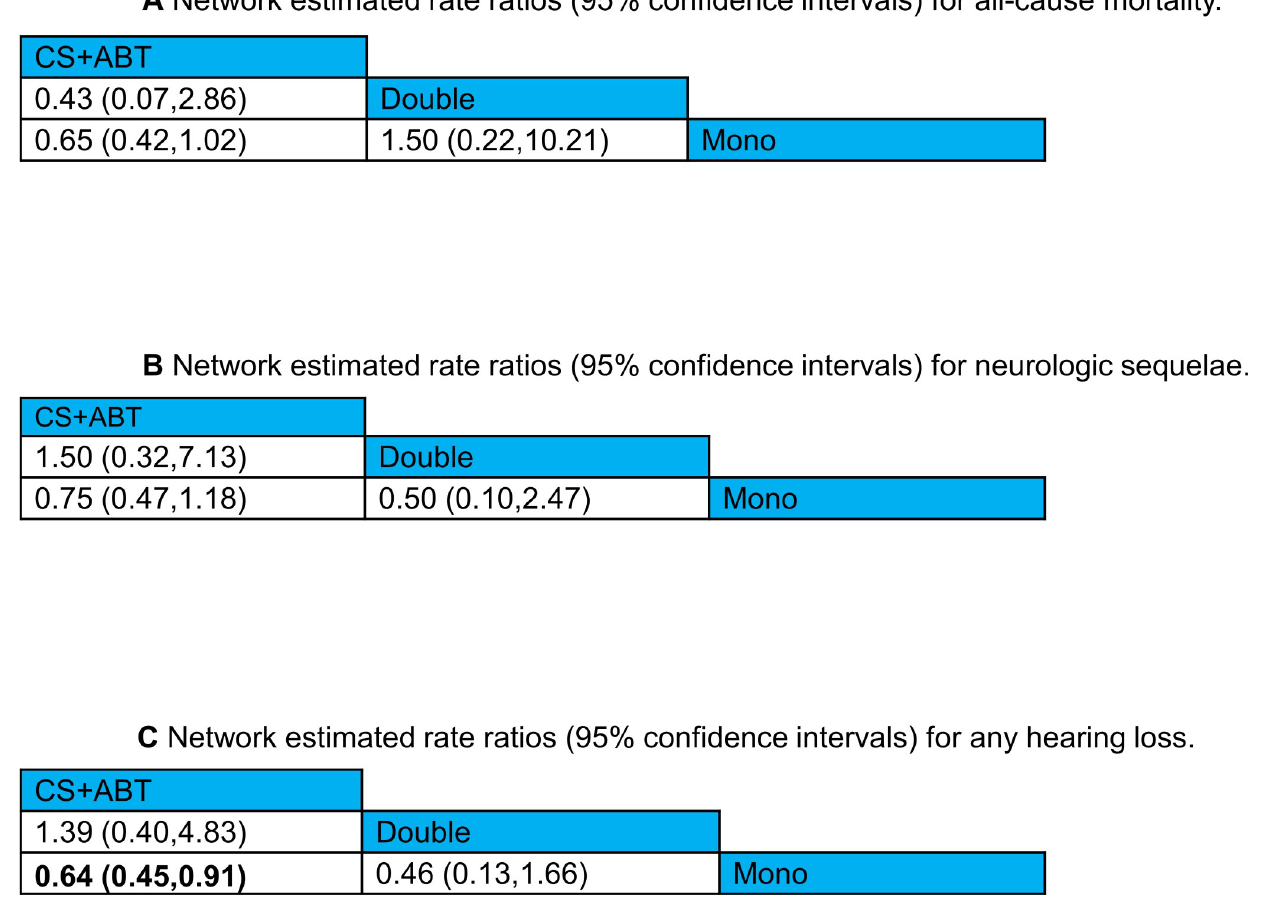
Fig 3. Network estimated risk ratio (95% CIs) of treatment comparisons for (a) all-cause mortality, (b) neurologic sequelae, and (c) any hearing loss. https://doi.org/10.1371/journal.pone.0232947.g003 Table 2. GRADE quality assessment of treatment comparisons for primary outcomes in adult bacterial meningitis. Treatment